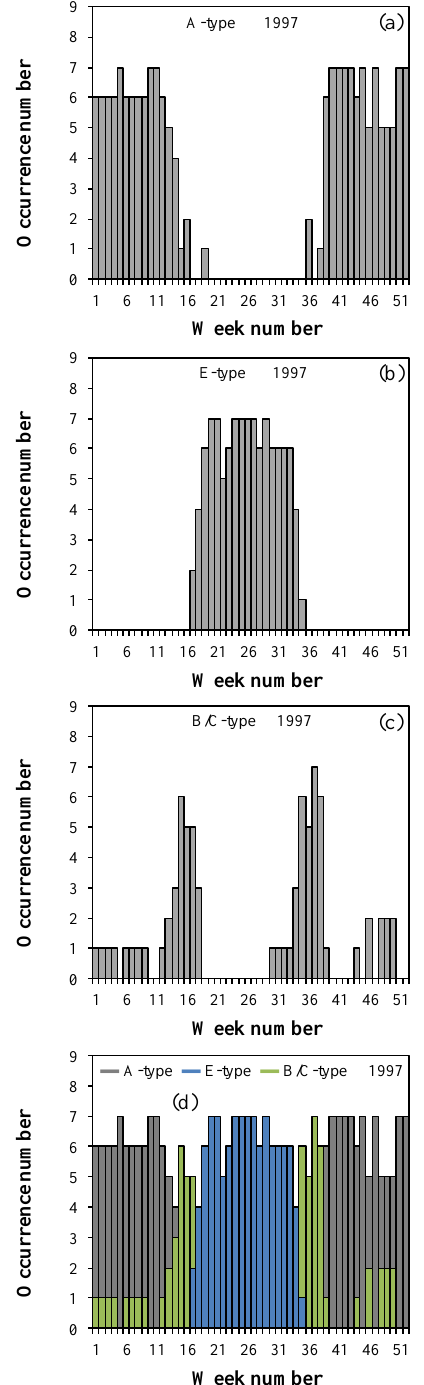
Figure 6. Same as Figs. 4 and 5 but for 1997, with clear seasonal be- haviours of the F-layer patterns except with regard to the secondary season of the B/C type during the period of January–February in (c) .